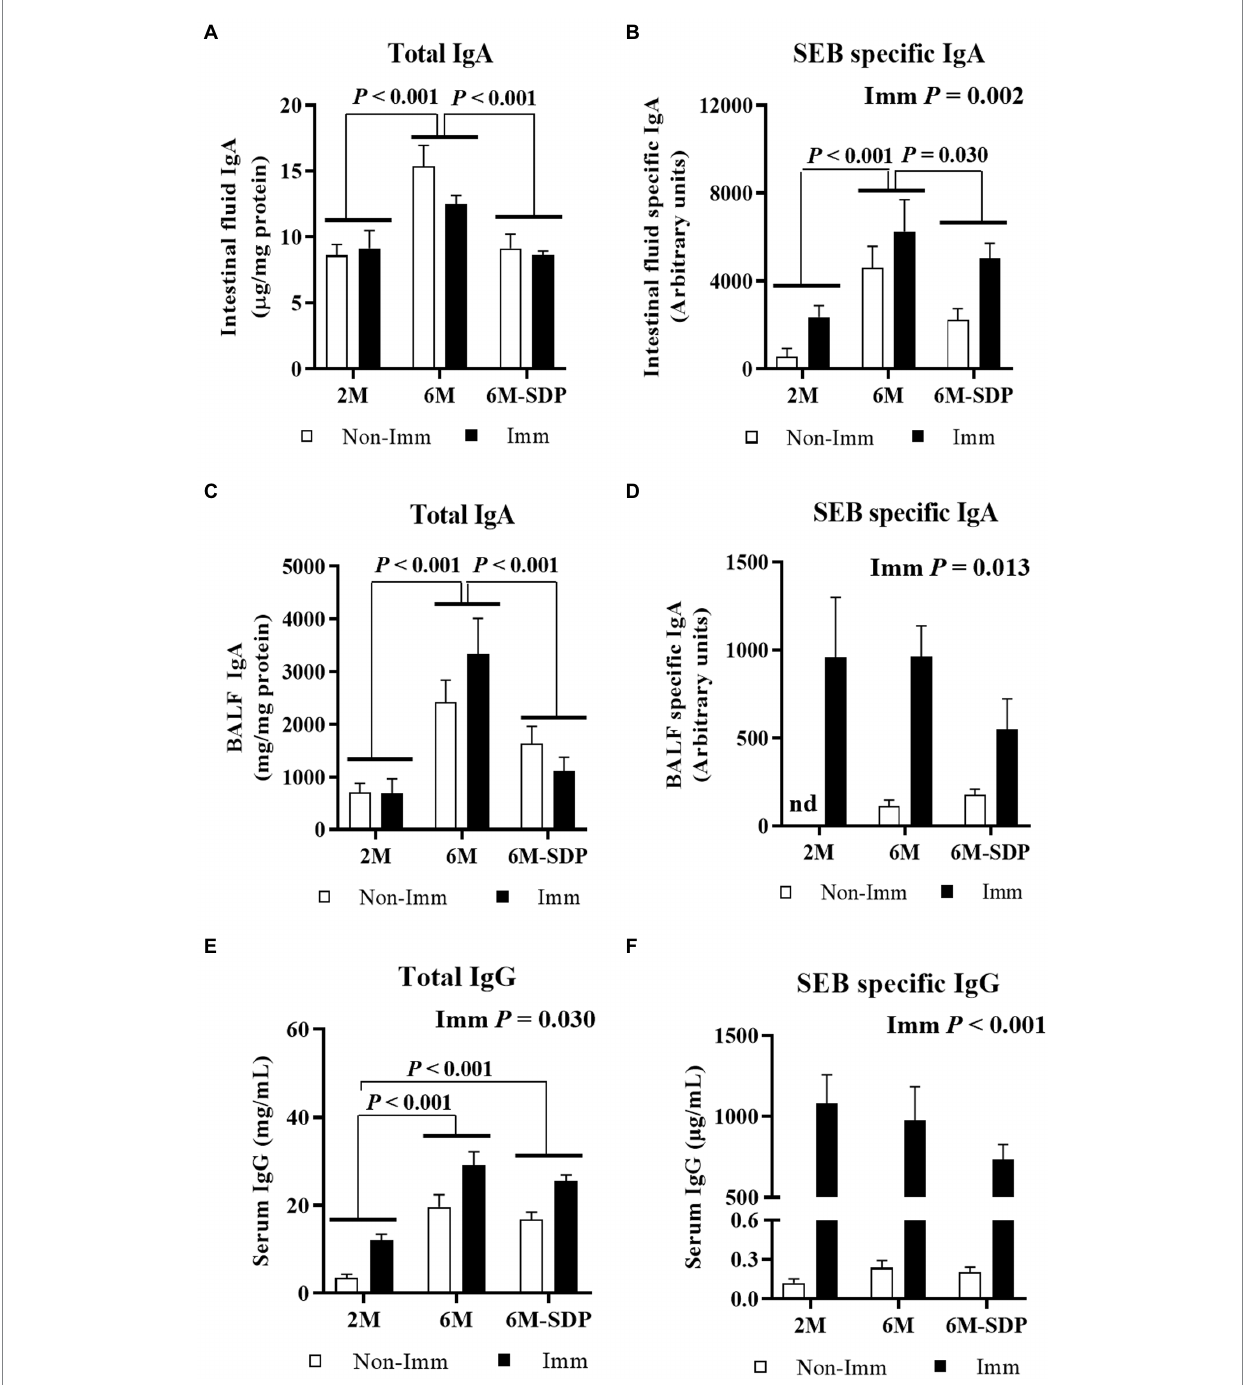
FIGURE 5 Immunoglobulins concentration. Total IgA concentration (A) and SEB-specific IgA titers (B) in intestinal fluid. Total IgA concentration (C) and SEB- specific IgA titers (D) in bronchoalveolar lavage fluid. Total IgG (E) and SEB-specific IgG (F) concentrations in serum. Open bars represent non- immunized ( Non-Imm ) mice; solid bars represent immunized ( Imm ) mice. Results are expressed as means ± SEMs ( n = 9–10 animals). Statistics: two- way ANOVA (age-feed and immunization factors; Fisher multiple comparison test). BALF, bronchoalveolar lavage fluid; IgA, immunoglobulin A; SDP, spray-dried porcine